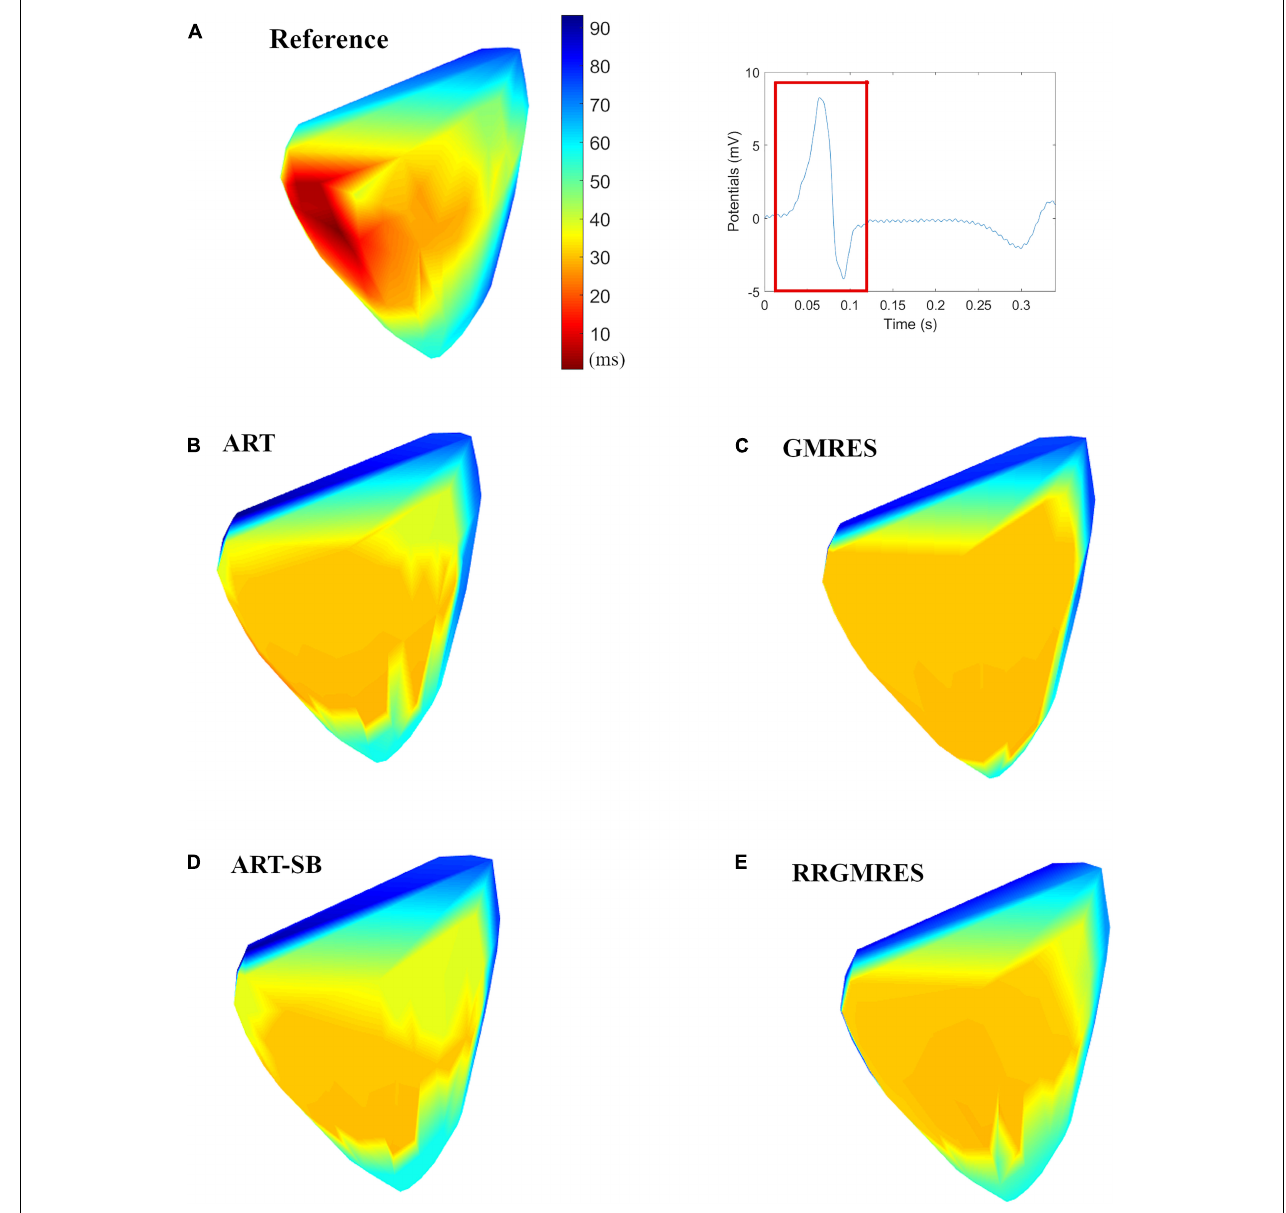
FIGURE 9 | Activation maps of the potentials during a 100 ms window (over QRS), applied to the paced rhythm Auckland dataset for: (A) Reference potentials and QRS window; (B) ART; (C) GMRES; (D) ART Split Bregman; (E) RRGMRES. All figures have the same colorbar than panel (A)